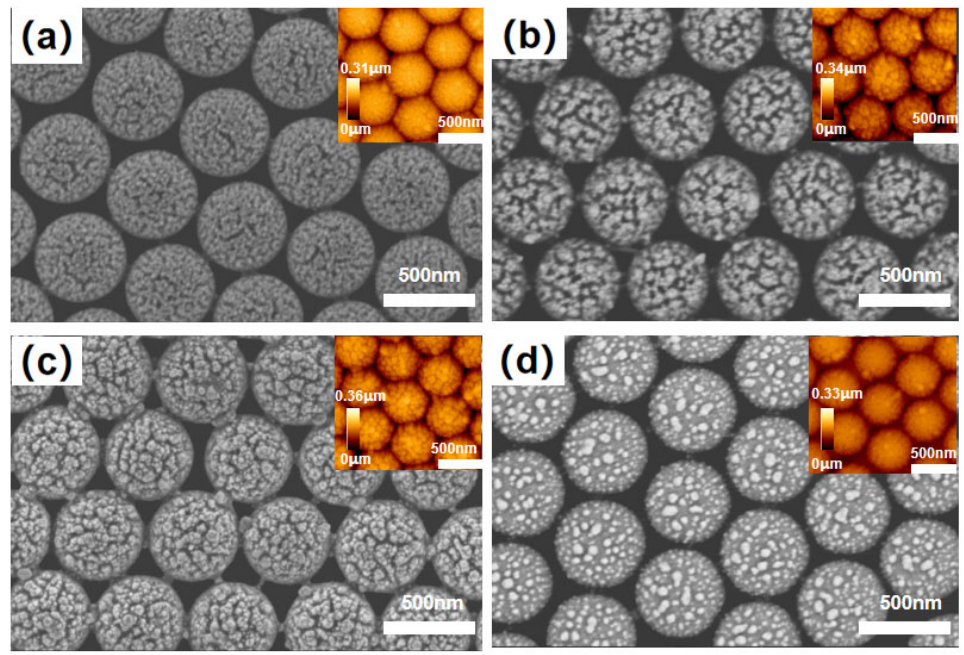
Figure 2. SEM and AFM images of the 10 nm Ag ‐ SiO 2 film after etching for ( a ) 0 s, ( b ) 30 s, ( c ) 60 s, ( d ) 90 s. ( d ) 90